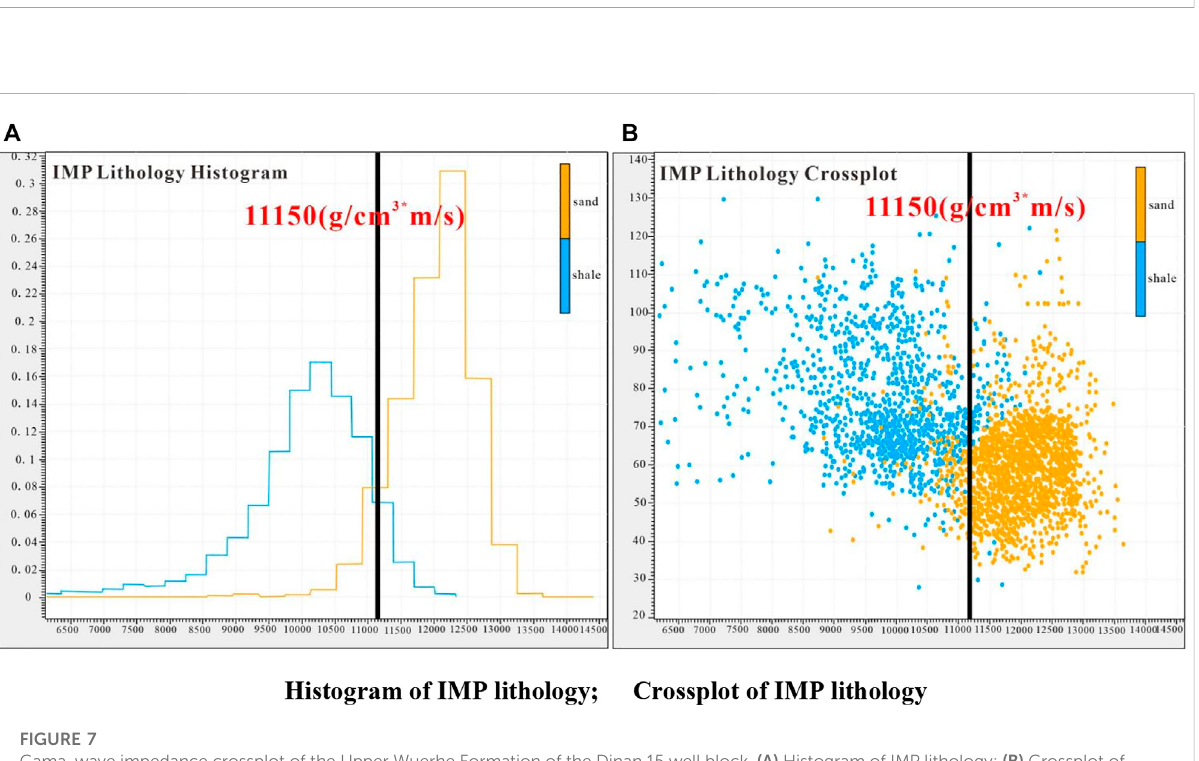
FIGURE 7 Gama-wave impedance crossplot of the Upper Wuerhe Formation of the Dinan 15 well block. (A) Histogram of IMP lithology; (B) Crossplot of IMP